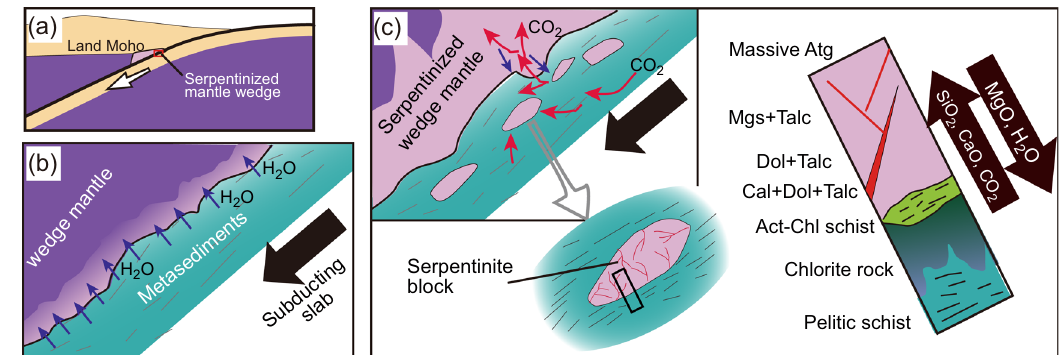
Fig. 3 Schematic illustration of carbonation in the mantle wedge. a Subduction zone setting at the leading edge of the mantle wedge. b Pervasive serpentinization at the leading edge of the mantle wedge is associated with the release of H 2 O from the subducting slab. c Localized carbonation of serpentinized mantle wedge and serpentinite blocks associated with production of carbonic